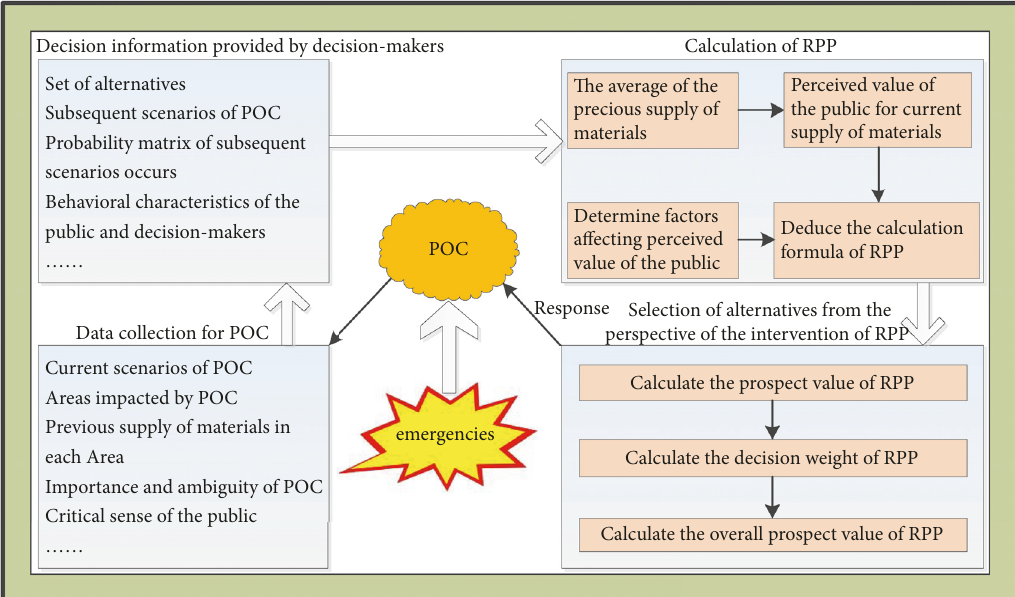
Figure 1: The description of the SRPP in POC and its solution with the proposed